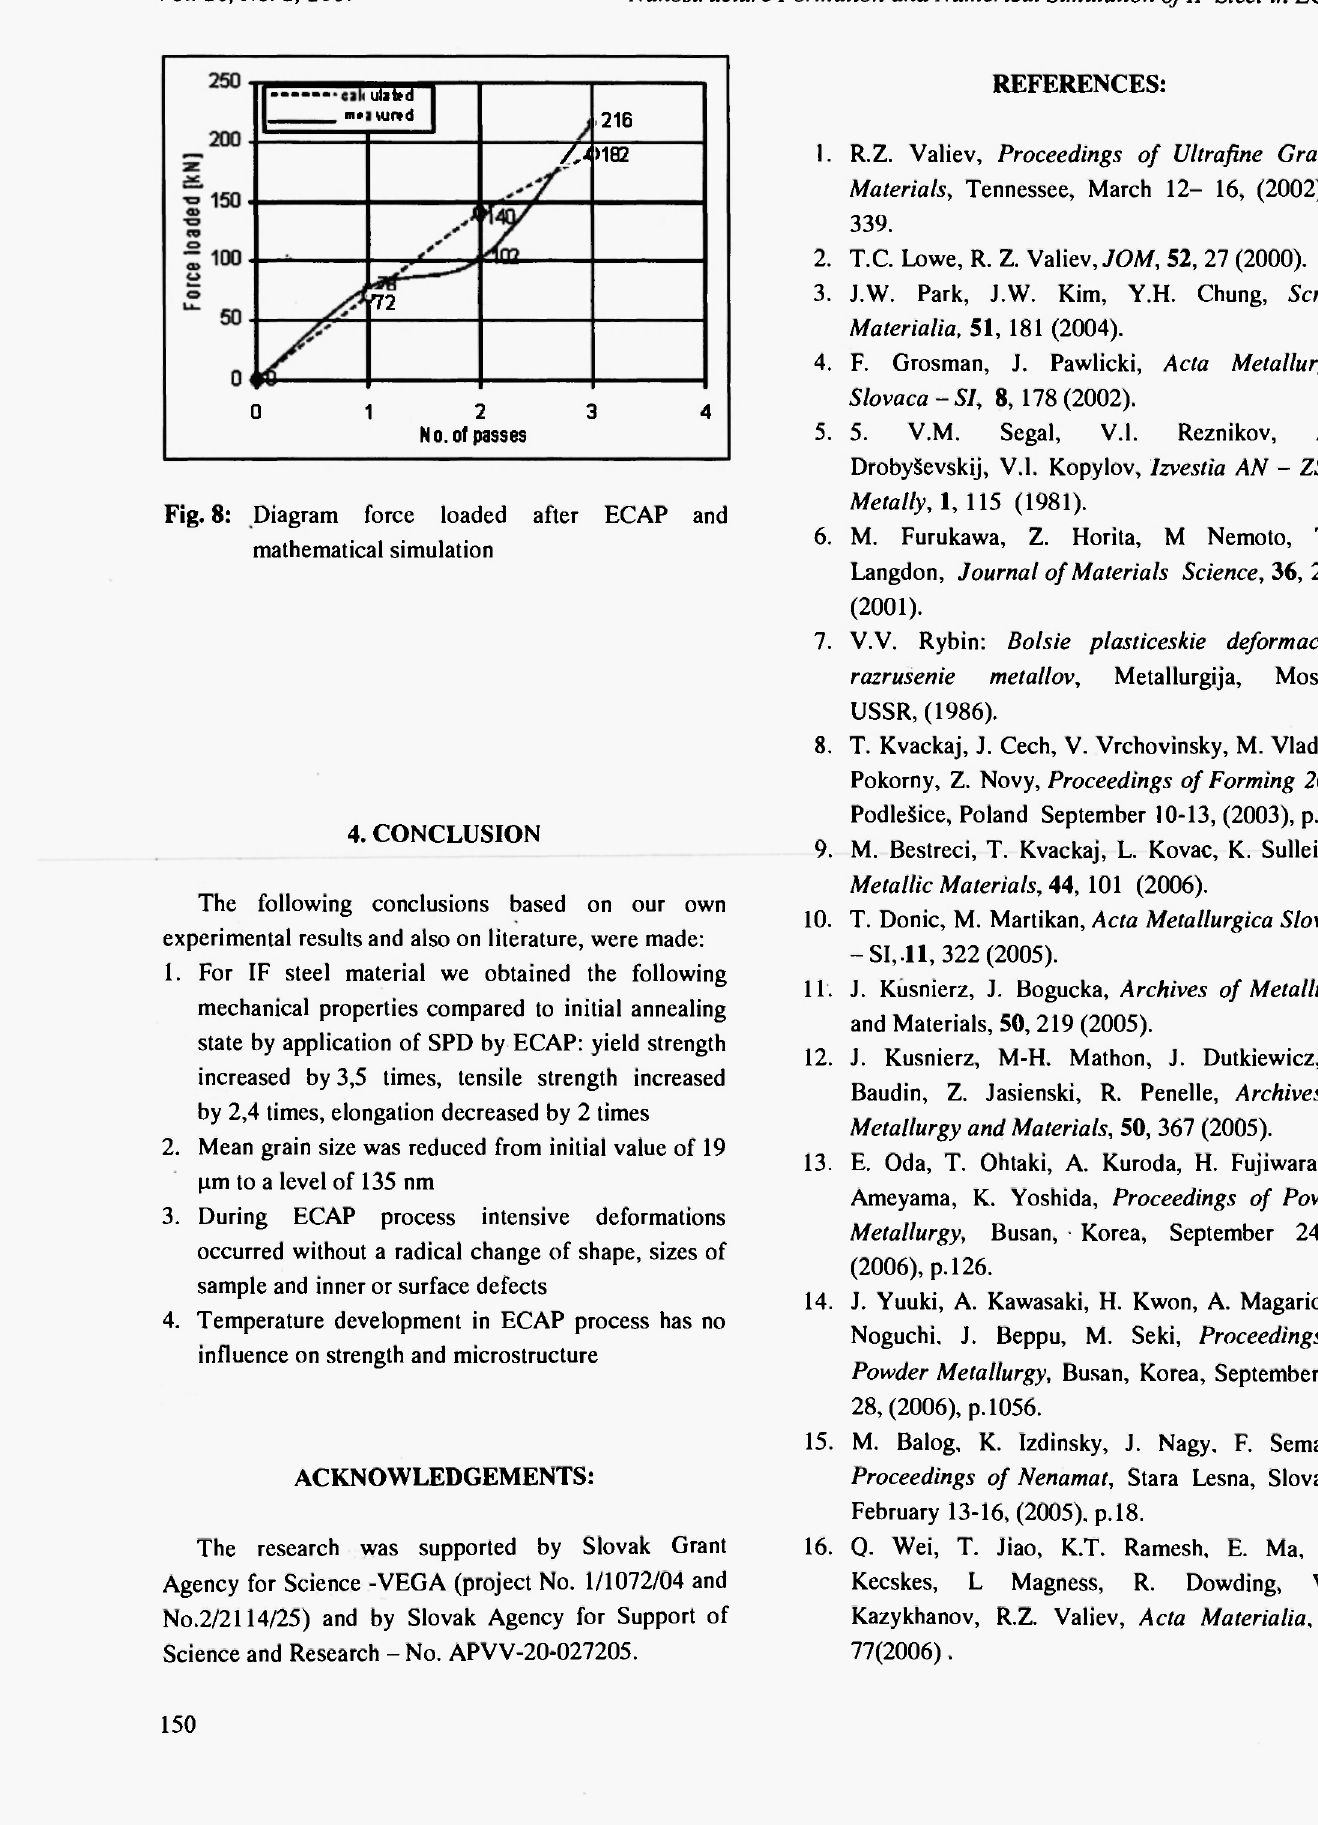
Fig. 8: Diagram force loaded after ECAP and mathematical